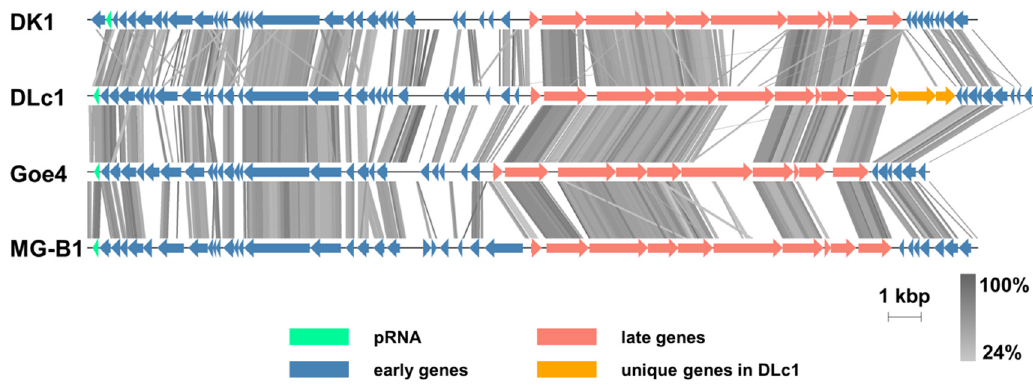
Figure 4. Pairwise genome alignment of DLc1 with its most related phages. The tblastx similarities are displayed as vertical grey lines, with grey levels representing the degree of similarity. The unique inserted genes in DLc1 are indicated as yellow arrows.